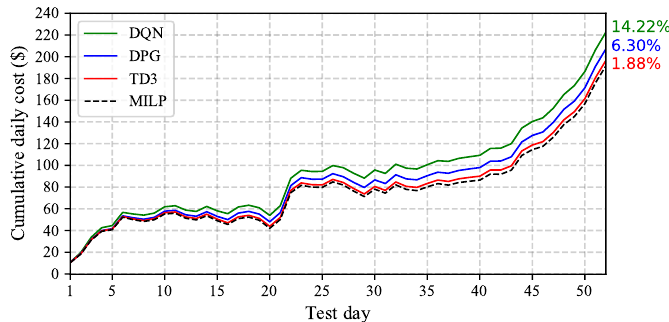
Figure 4. Average daily cost evaluated over the test dataset for the examined deep reinforcement learning (DRL) methods with 10 different random seeds.